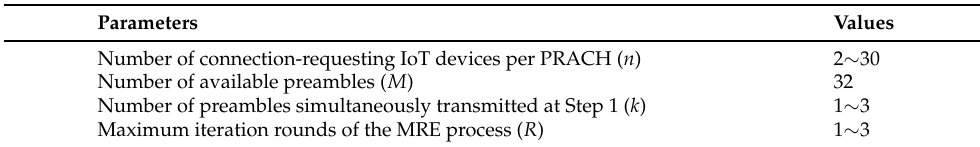
Table 1. Simulation parameters and